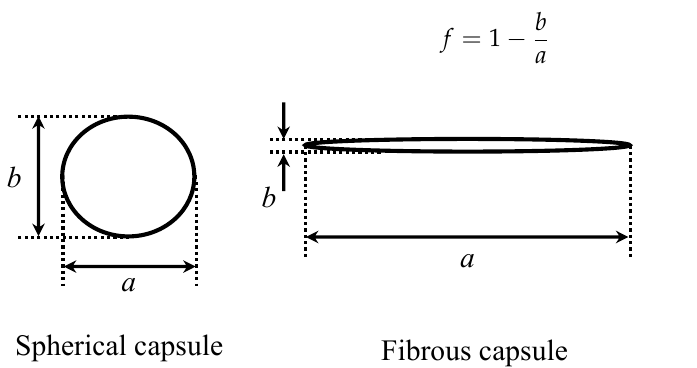
Spherical capsule Figure 6. Schematic illustration of the capsule shape projected and the definition of “ a ” and “ b ”. From this equation, the value of flattening, f , can be calculated as “0”, when the value of “ a ” is the same as that of “ b ”, namely in the case of the projected capsule shape being a perfect circle. On the other hand, if the value of “ a ” is significantly larger than that of “ b ”, the value of f is close to “1”. Figure 7 shows the distribution of values of flattening of capsules synthesized from unheated or heated prepolymer solutions. The flattening distribution of capsules synthesized from unheated prepolymers (open circle) shows that most capsules have less than 0.2 for their flattening values and those without a capsule have f > 0.5. Thus, the projected shapes of most of the capsules are close to a perfect circle, and no fibrous capsule is synthesized from the prepolymer solution without heating. The flattening distribution of the capsules synthesized from the prepolymer solution with heating (solid circle) shows that the ratio of capsules having less than f = 0.2 to all of the capsules occupies 60% and capsules with a f -value larger than 0.6 occupy approximately 30%. Here, the capsules with a f -value larger than 0.6 are defined as the fibrous ones. Therefore, 70% of the projected shapes for all the capsules were close to a circular shape and 30% were of a fibrous shape when the capsule was synthesized from the prepolymer solution after heating. Conclusively, the ratio of fibrous capsules to all of the capsules increased when synthesizing from a concentrated prepolymer solution under a mild agitation condition.